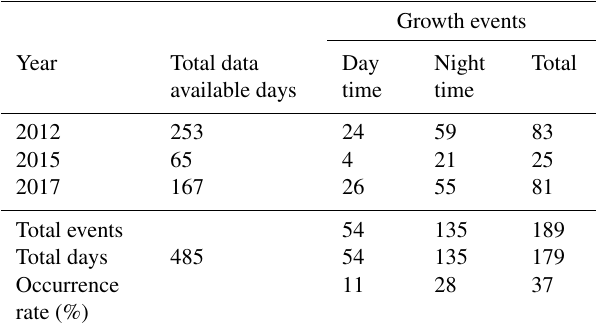
Table 4. Summary of the growth events, which did not follow the NPF events, obtained using the NAIS